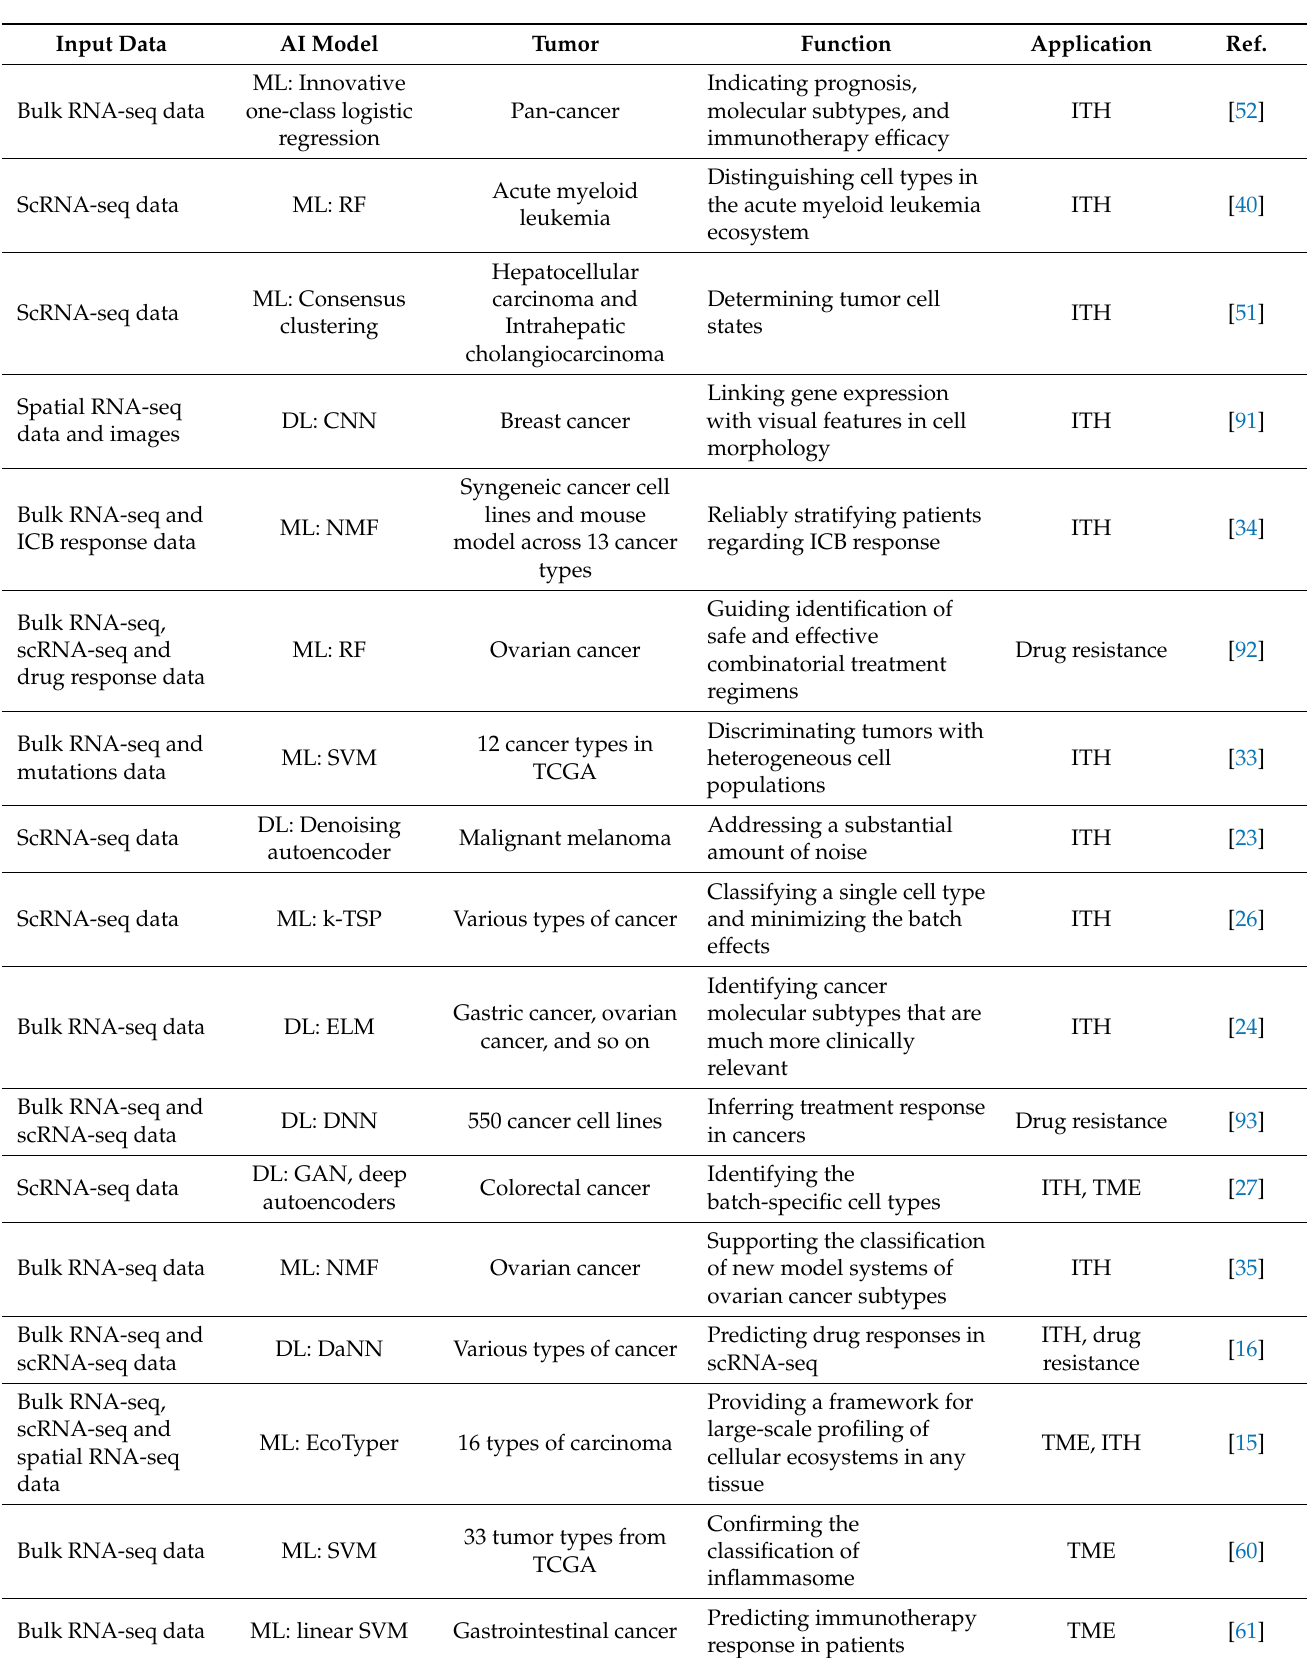
Table 1. Application of AI approaches in transcriptomic